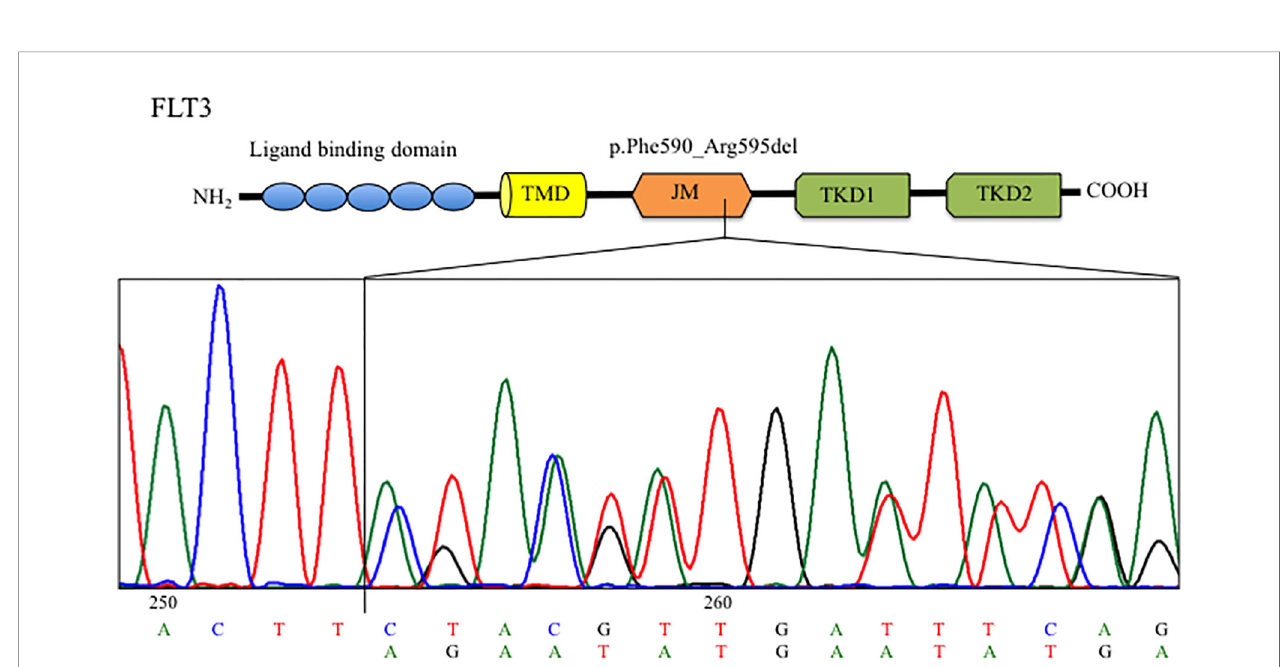
FIGURE 2 | Sanger sequencing chromatogram showing the FLT3 deletion identi fi ed in the BM at diagnosis. TMD, transmernbrane domain; JMD, juxtamembrane domain; TKD, tyrosine kinase domain.